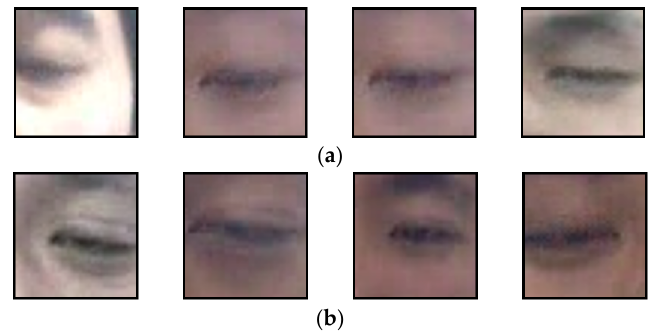
Figure 10. Error images from the classification of open and closed eye images using the proposed method. ( a ) Type 1 error; ( b ) Type 2 error.